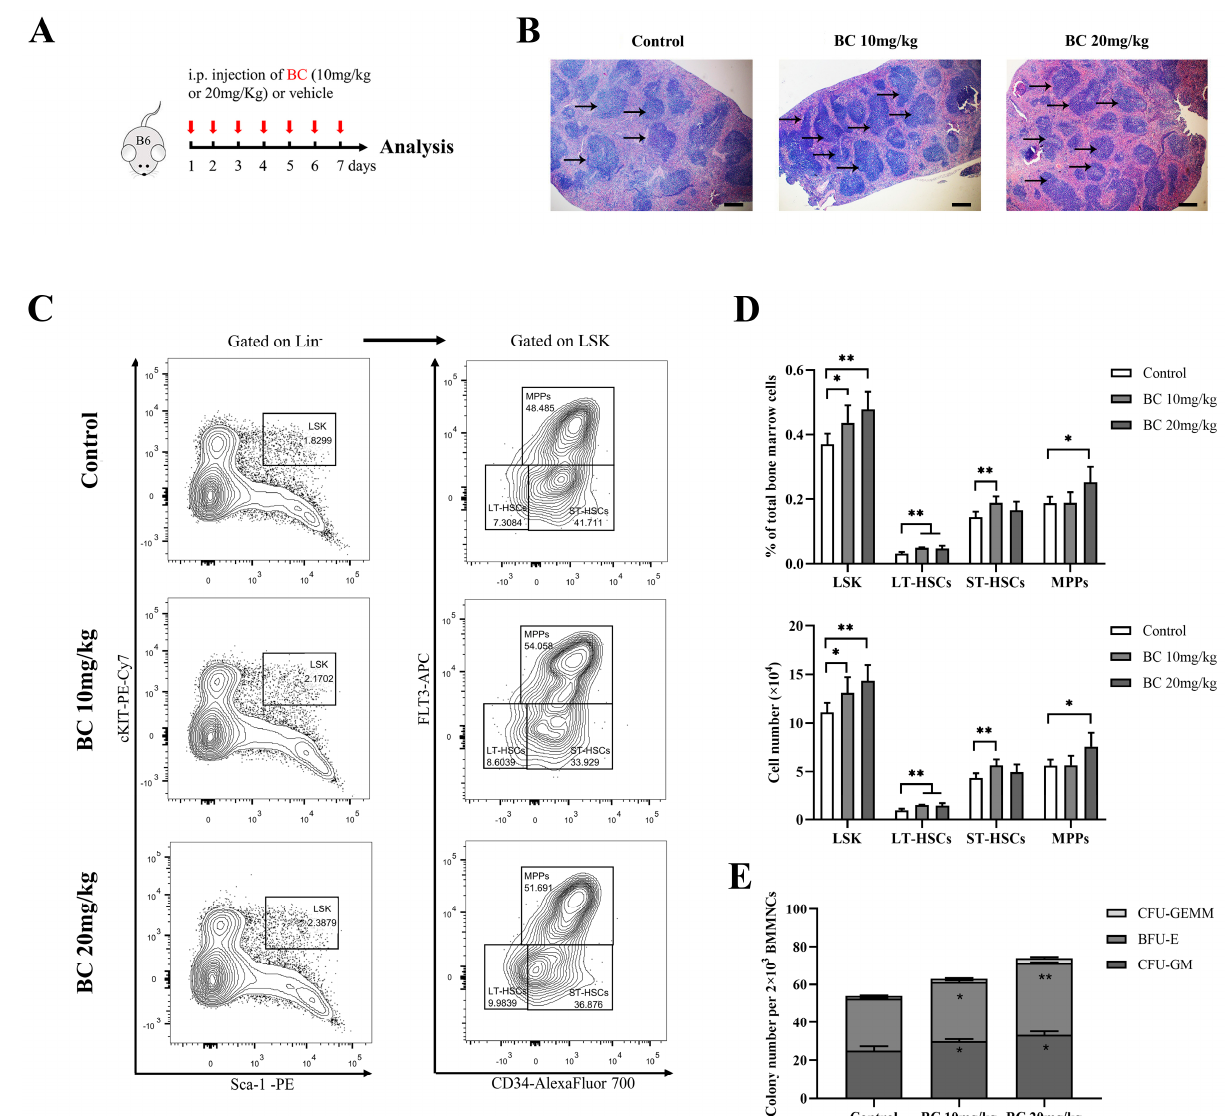
Figure 5. BC administration increases the proportion of HSPC population and colony − forming ability of BMMNCs in healthy mice. ( A ) Experimental schematic of BC administration in healthy mice. C57BL/6 mice were administered once daily with BC (10 or 20 mg/kg) or vehicle by intraperitoneal (i.p.) injection for 7 days ( n = 5). Mice were sacrificed 24 h after the last injection. B6 represents C57BL/6 mice. Red arrows indicate BC injection timepoints. ( B ) Histological analysis of spleen tissues by hematoxylin and eosin (HE) staining. Scale bar: 200 μ m. Black arrows indicate the white pulp of spleen. ( C ) Representative flow cytometry profiles showing the percentage of LSK (left), LT − HSCs (LSKCD34 - FLT3 - ), ST-HSCs (LSKCD34 + FLT3 - ) and MPPs (LSKCD34 + FLT3 + ) (right) in BMMNCs from control or BC (10 or 20 mg/kg) treated mice. Gates shown identify the LSK populations from Lineage - (Lineage negative cells) and the LT − HSC, ST − HSC and MPP populations from LSK cells. ( D ) The proportions and absolute number of LSK, LT − HSCs, ST − HSCs and MPPs in BMMNCs from control or BC (10 or 20 mg/kg) treated mice in flow cytometry analysis as shown in ( C ) ( n = 5). ( E ) The numbers of CFUs formed by BMMNCs from control or BC (10 or 20 mg/kg) treated mice ( n = 3). All data are shown as mean ± SEM, * p < 0.05, ** p < 0.01 (Student’s t test) versus control.